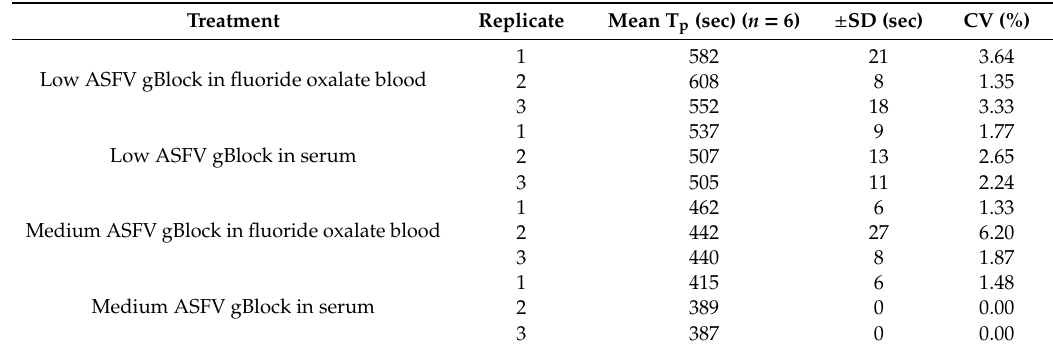
Table 3. Assessment of intra-assay variation of ASFV LAMP and coe ffi cient of variation.